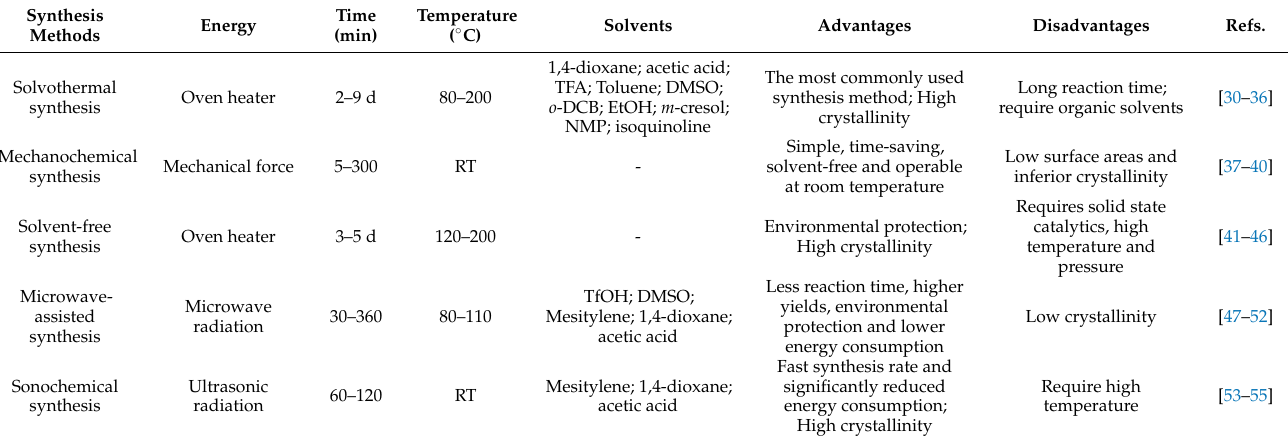
Table 1. The synthetic approaches of